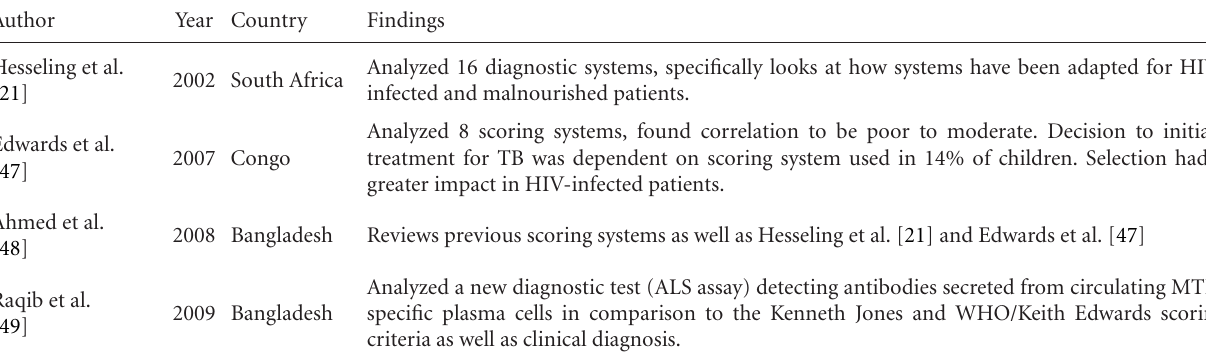
Table 3: Studies evaluating and comparing multiple diagnostic